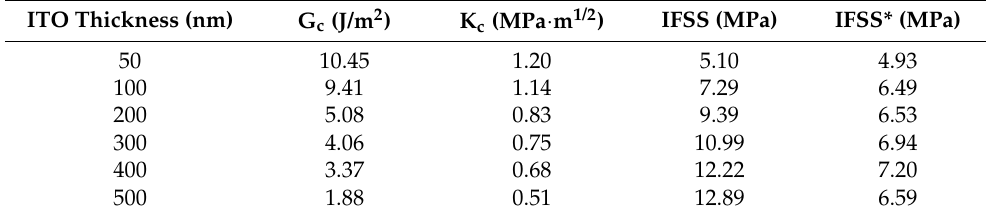
Table 2. The G c , K c , IFSS and IFSS* values of different